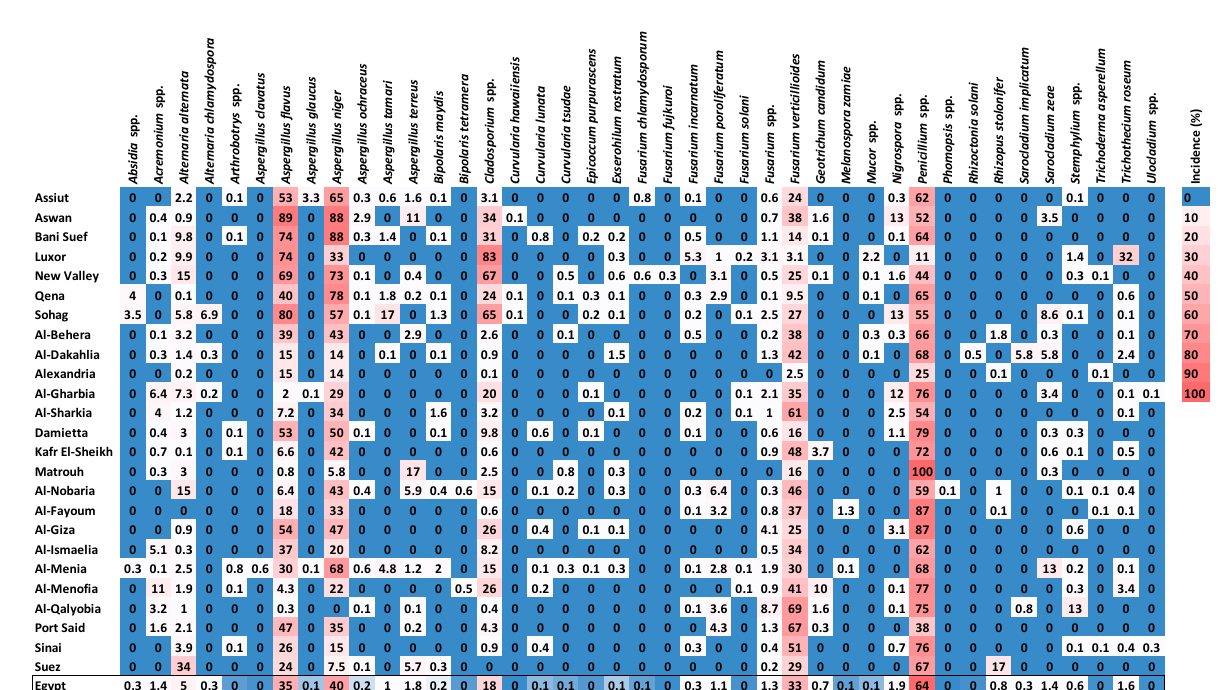
Figure 2. Heatmap showing frequencies of 42 maize seed-borne fungus species in each of the 25 maize-growing governorates of Egypt and for the national average over Egypt. Gradients of fre- quency key on the right vary from 0 (blue) to 100% (red).